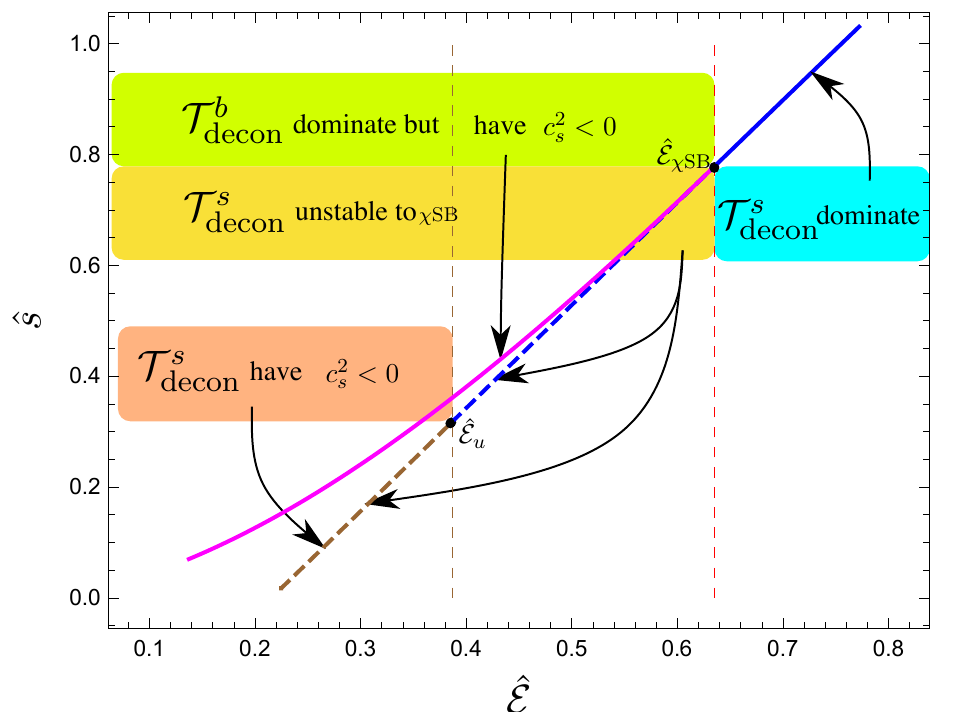
Figure 20 . Phase diagram in the microcanonical ensemble at µ/ Λ = 0: the reduced entropy density ˆ s , see (6.1), versus the reduced energy density ˆ the theory. Vertical dashed lines indicate critical reduced energy densities ˆ spontaneous chiral symmetry breaking, and ˆ of the spatial translational invariance in